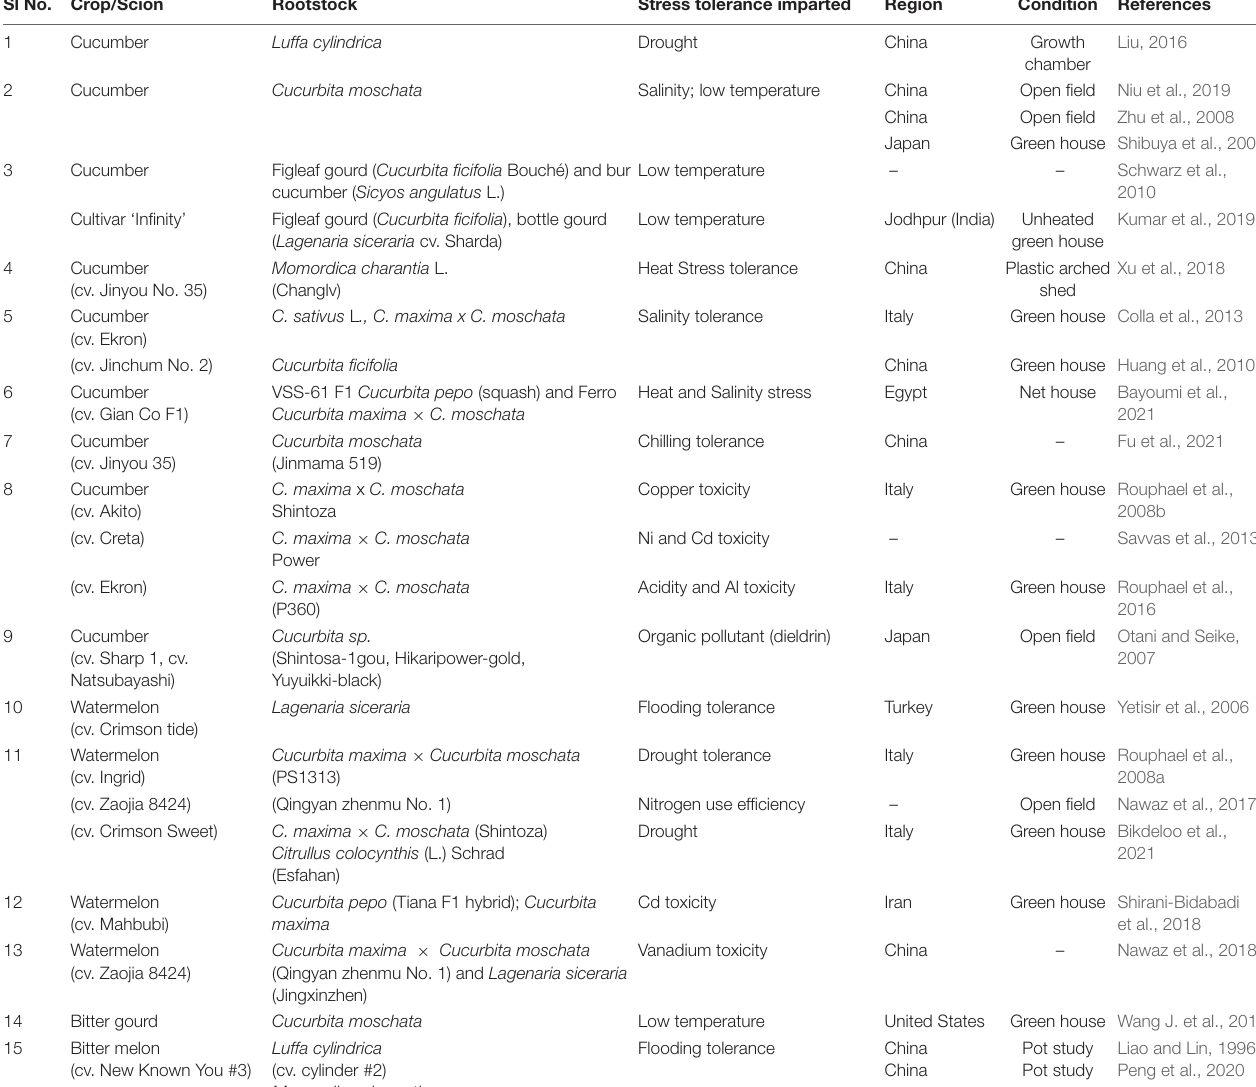
TABLE 6 | Rootstocks for combating abiotic stress in cucurbits. Sl No. Crop/Scion